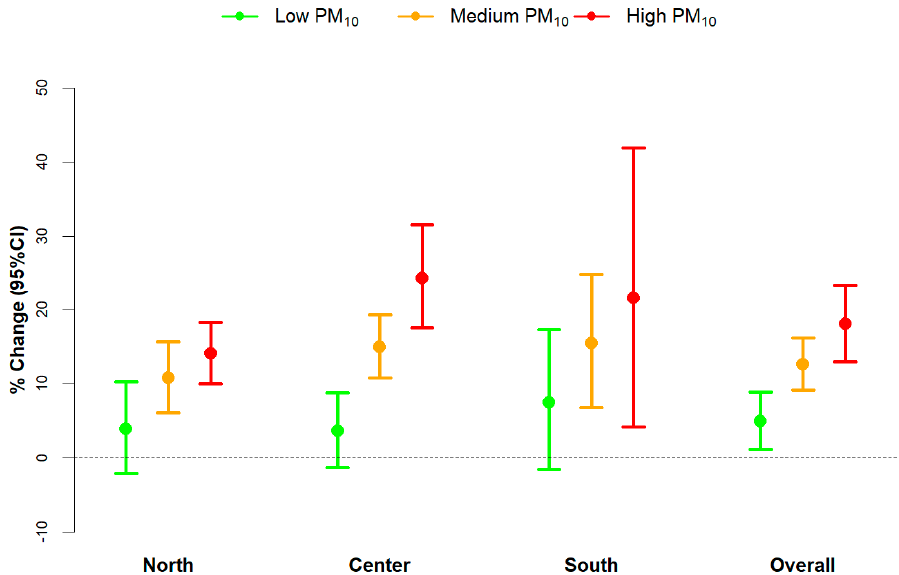
Figure 3. Area-specific (North, Center, South) and overall meta-analytical estimates of the heat effects, stratified by levels of PM10. Estimates are given as % change in non-accidental mortality, and 95% confidence intervals (95% CI) for mean air temperature increases between the 75th to 99th percentile of city-specific temperature distributions, by levels of PM10 (defined as “low”, “medium”, and “high” based on 5th, 50th, and 95th percentiles of city-specific PM10 distributions).